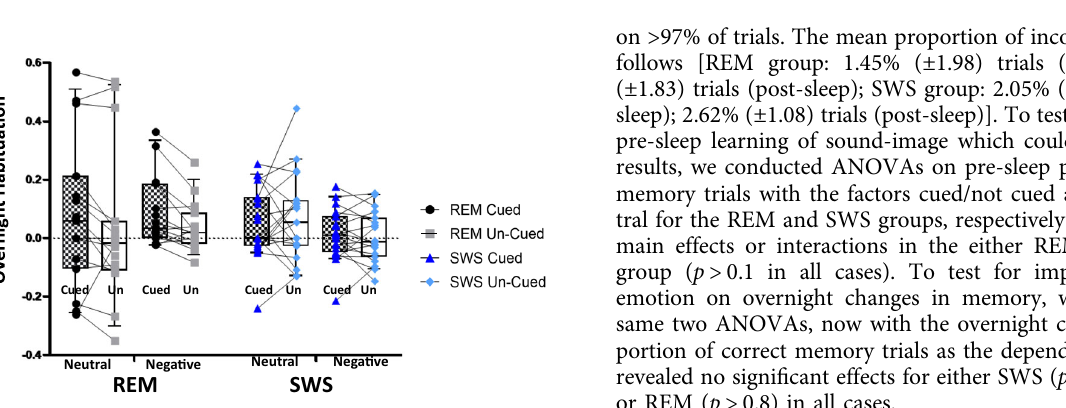
Fig. 2 Overnight habituation of subjective arousal. Cueing (black and white checked boxes) was associated with a signi fi cantly greater overnight habituation than Un-cued (white boxes) in the REM group (Cued REM = black circles and Un-cued REM = gray squares). Thus, a Cueing x Emotion ANOVA on REM sleep gave the main effect of Cueing ( p < 0.02). Follow up t tests showed that this was driven by responses to negative stimuli ( p = 0.006), where 12 of the 15 participants showed the effect (see lines joining Cued an Un-cued). A trend ( p = 0.12) was also present in neutral stimuli, where 13 out of 15 participants showed this effect, but there was more variability in the amount of habituation that occurred. The same ANOVA on SWS showed no effect of Cueing. Instead, there was a main effect of emotion, with neutral items habituating more than negative items ( p = 0.02). Box and whisker plots show the 10 th and 90 th percentiles. REM group, N = 15, SWS group, N = 18.